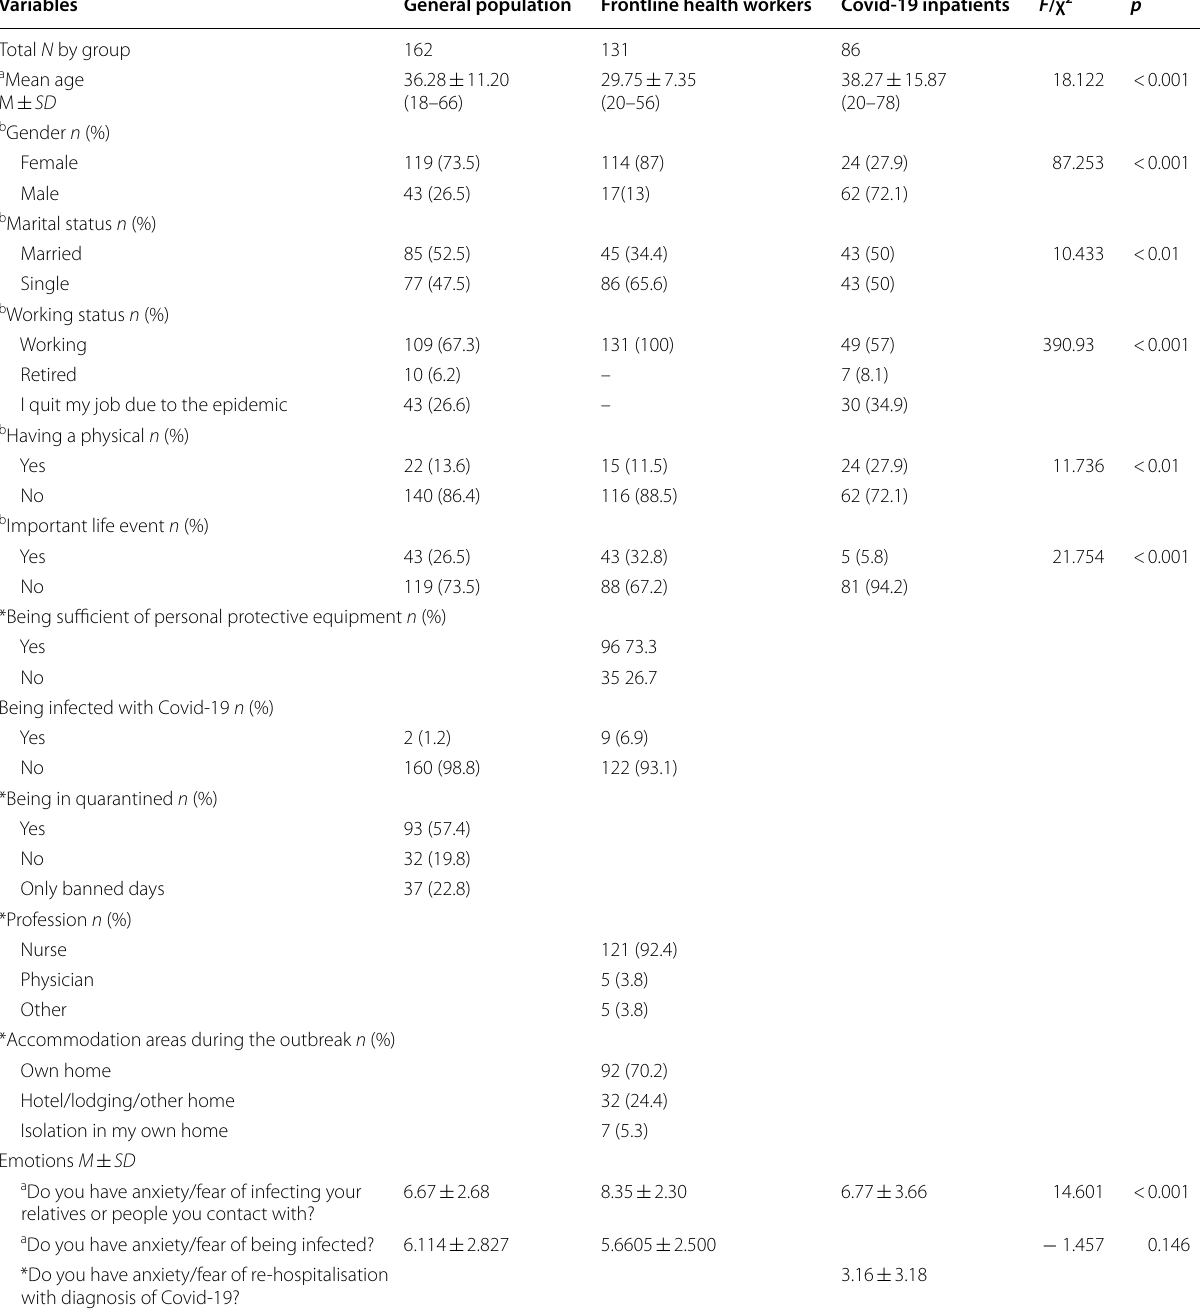
Table 1 The individual characteristics of